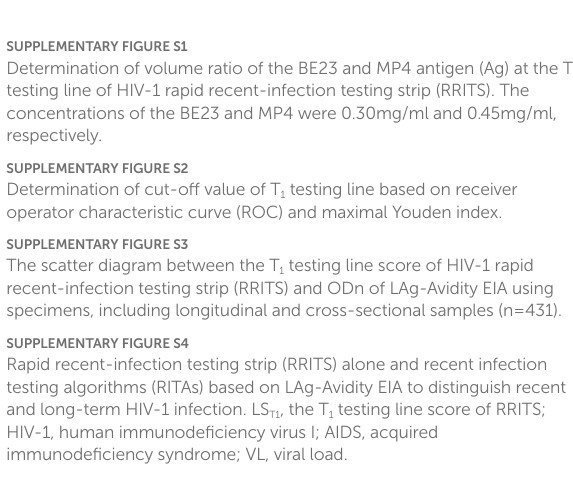
SUPPLEMENTARY FIGURE S2 Determination of cut-off value of T 1 testing line based on receiver operator characteristic curve (ROC) and maximal Youden